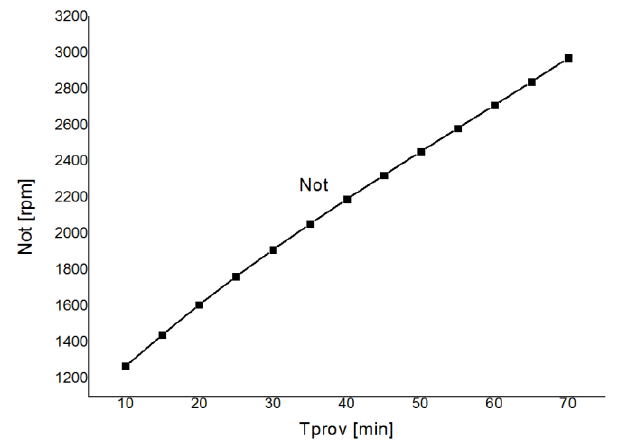
Figure 4. Dependence of flue gasses temperature in the stack throat and in the stack Tkom (°C) on the working time Tprov (min), for the boilers with power output up to 100 kW.